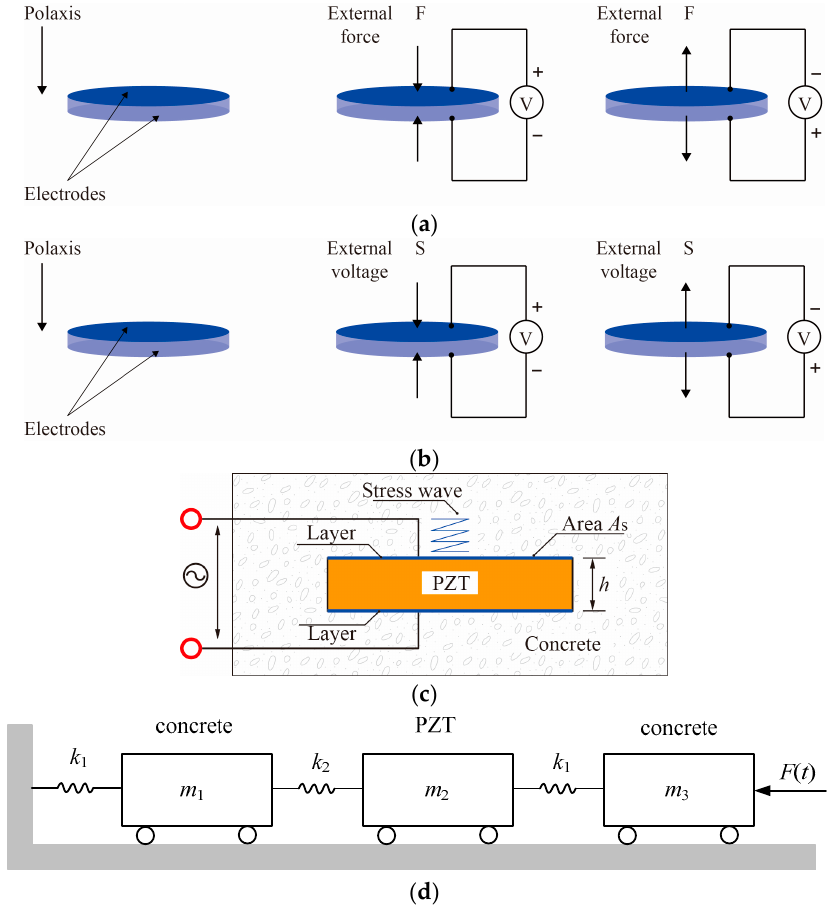
Figure 4. Piezoelectric effects and smart aggregate function. ( a ) Direct piezoelectric effect (sensing); ( b ) Inverse piezoelectric effect (actuating); ( c ) Smart aggregate model; ( d ) Mechanics model of the embedded PZT sensor.